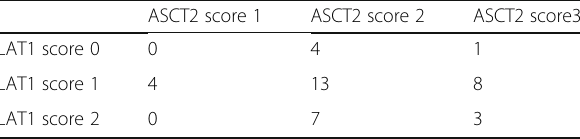
Table 2 Distribution of ASCT2 and LAT1 scores in 40 prostate cancer